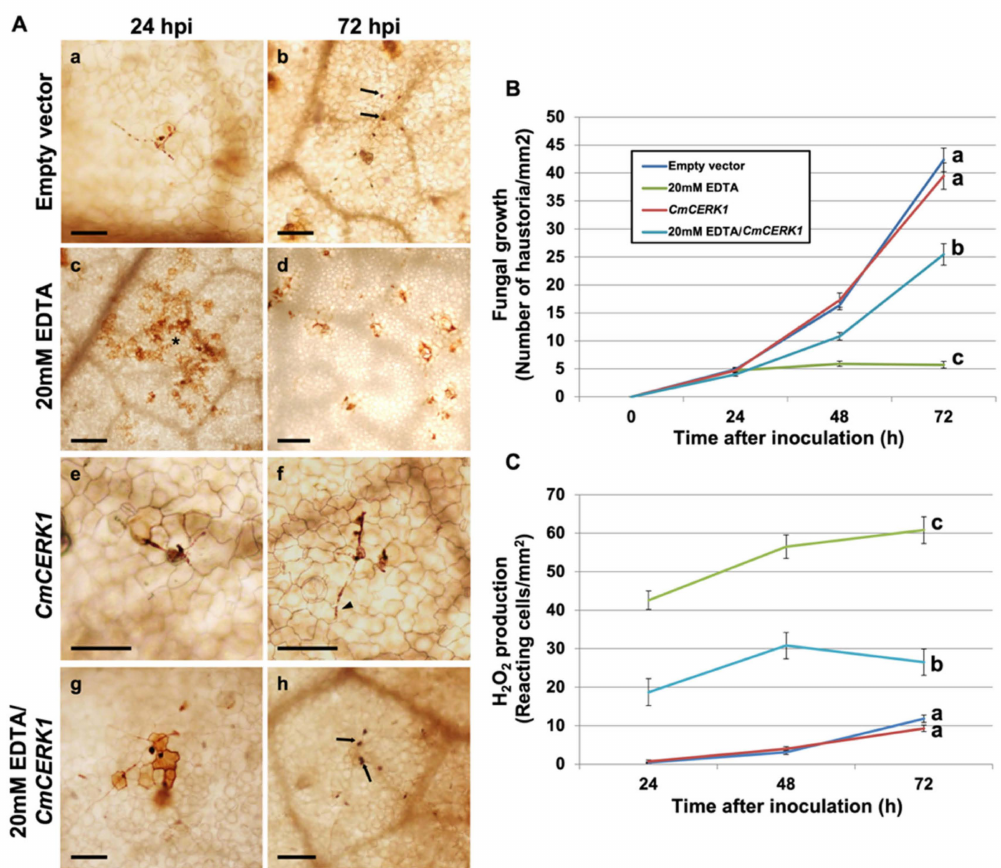
Figure 5. Effect of EDTA on fungal growth and production of hydrogen peroxide. Melon plants were treated with EDTA as described in the Materials and Methods. For RNAi silencing, melon cotyledons were agroinfiltrated, inoculated with P. xanthii 24 h after infiltration, and treated with EDTA 24 h after inoculation. Silencing of the melon chitin receptor gene CmCERK1 was carried out to interfere with host chitin signalling. An empty vector was used as a negative control for RNAi silencing experiments. ( A ) Visualization of fungal structures and H 2 O 2 -producing cells. Detection of hydrogen peroxide was performed by the 3,3 (cid:48) -diaminobenzidine (DAB) uptake method. Pictures were taken at 24 and 72 h after inoculation with P. xanthii . Arrowheads indicate P. xanthii haustoria; arrows indicate P. xanthii hyphae, and asterisks indicate reactive epidermal cells with H 2 O 2 accumulation. Bars = 50 µ m ( e , f ), 100 µ m ( a , b , g , h ), and 200 µ m ( c , d ). ( B ) Estimation of fungal growth by haustorial counting. The growth of P. xanthii is expressed as the number of haustoria per mm 2 of transformed tissue. The values are the means of 30 samples from three independent experiments ± standard error. ( C ) Time course analysis of the accumulation of H 2 O 2 in melon cotyledons. Detection of H 2 O 2 was performed by the DAB uptake method. The reactive epidermal cells were identified as those containing brown–red precipitates (asterisks). Data represent the number of reactive cells per mm 2 and are the means of 30 samples from three independent experiments ± standard error. Values with different letters in ( B , C ) are significantly different at p = 0.05 according to Fisher’s least significant difference test